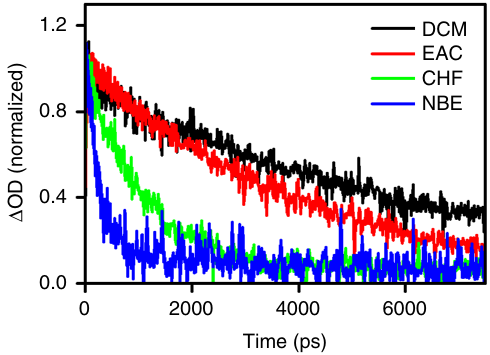
Fig. 2 Decays of 1 2 ± at 470 nm in the solvents indicated in the plot. The solvent response was subtracted from decays and the chirp correction was made according to Surface Xplorer, and then the decays were normalized by the maximum absorption change, to be plotted together. Solvents: